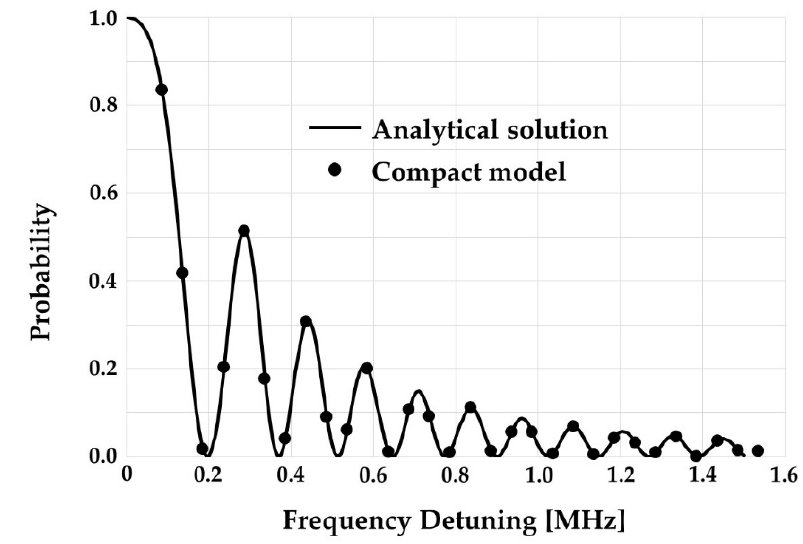
Figure 8. A 35 kHz frequency compensated simulated chevron cross-section vs. analytical chevron cross-section for P 0 for the third peak of the Rabi oscillation ( τ p = 8.445 µ s) in the case of trapezoidal integration method.